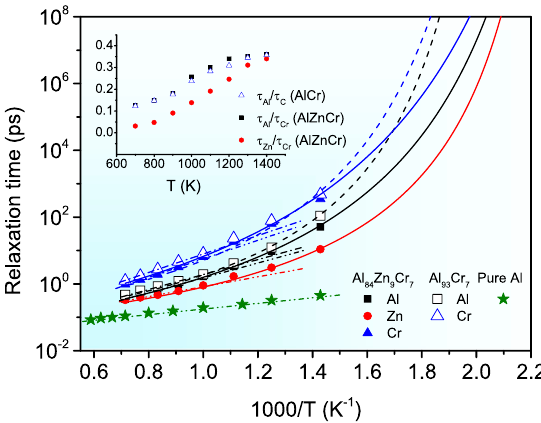
Fig. 3 Arrhenius plot of the viscosity for Al − Cr binary alloy as well as the Al − Zn − Cr ternary alloy. The simulation data for pure liquid Al are also included for comparison. The dashed lines correspond to the Arrhenius fi t in the temperature range 1400 − 1000 K for Al − Cr and Al − Zn − Cr, and a range from 1700 to 700 K for pure